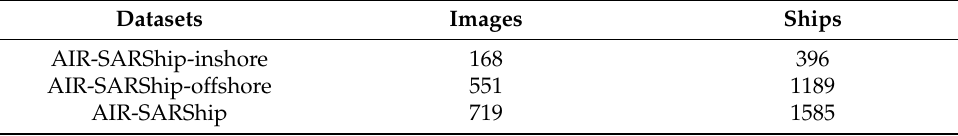
Table 6. AIR-SARShip-inshore and AIR-SARShip-offshore.